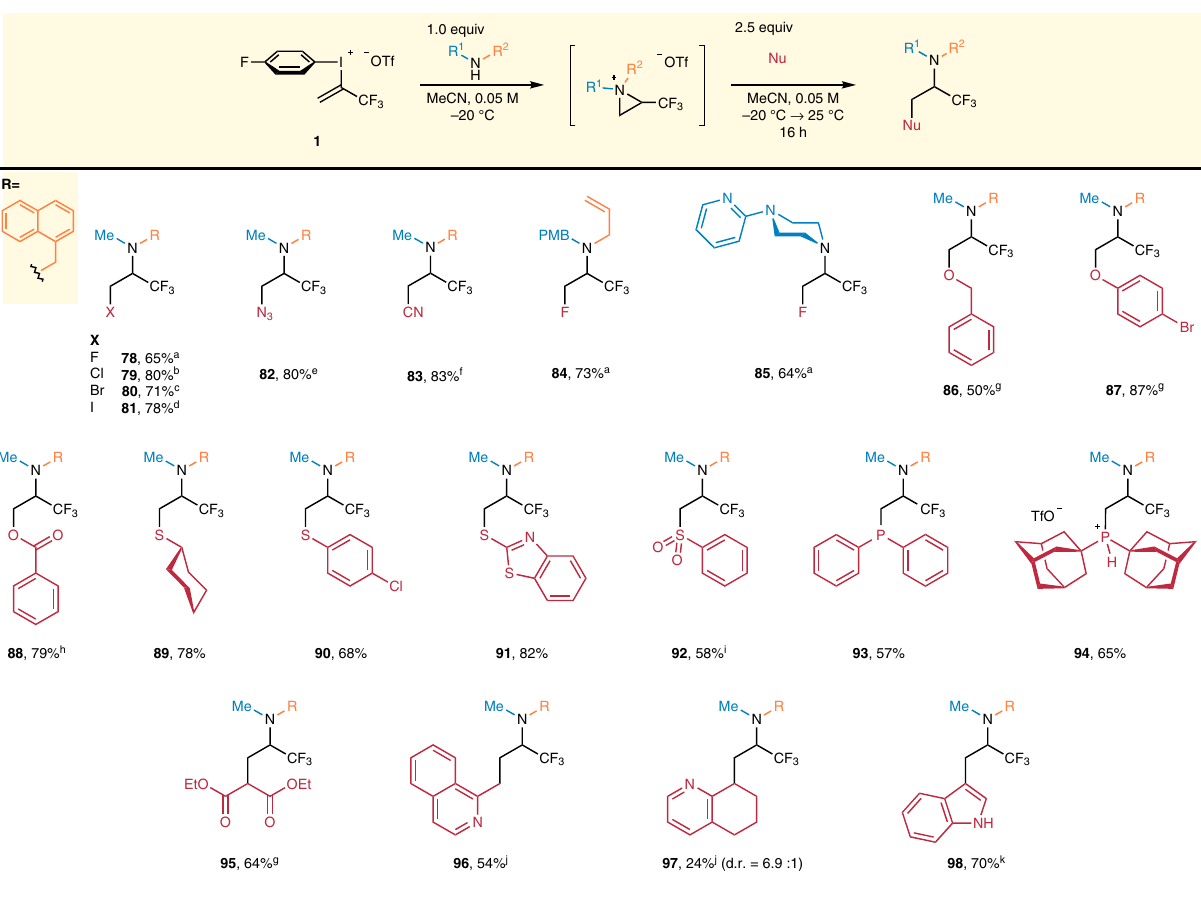
Fig. 5 Scope of tri fl uoropropylamines. 1st stage: 1 (0.2 – 0.3 mmol) added at 0.3 mmol h − 1 rate, R 1 R 2 NH (1.0 equiv.), MeCN, c = 0.05 M, − 20 °C, 0.16 h mmol − 1 ; 2nd stage: Nu (2.5 equiv.), − 20 °C → 25 °C, 16 h. a Nu = CsF, b Nu = tetrabutylammonium chloride, c Nu = tetrabutylammonium bromide, d Nu = NaI, e Nu = NaN f Nu = KCN, g NuH was deprotonated previously by 1.0 equiv. NaH in THF, h Nu = sodium benzoate, i Nu = 3 ,